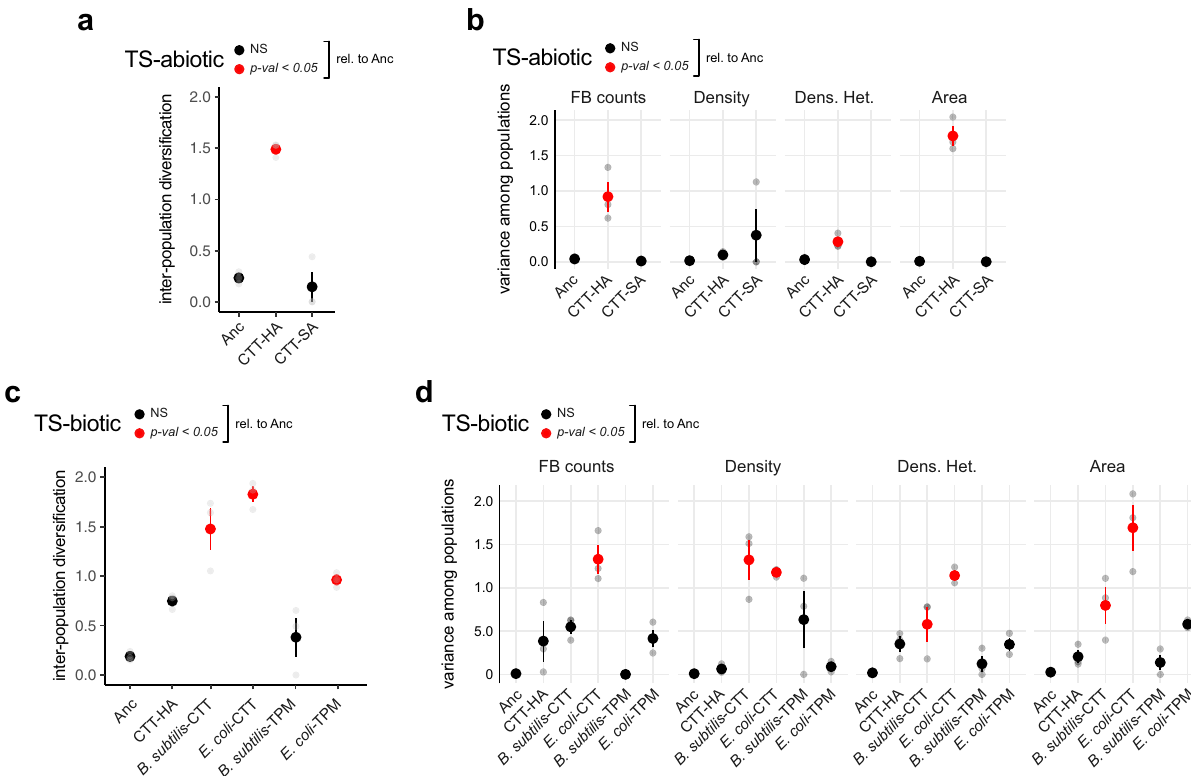
Fig. 5 Deterministic limitation of stochastic latent-phenotype diversi fi cation by MyxoEE-3 selective environments. a , c Morphological diversity among replicate TS-abiotic ( a ) and TS-biotic ( c ) populations evolved in the same selective environment compared to diversity among Anc subclones. b , d Variance of single morphological traits distributions calculated across TS-abiotic ( b ) and TS-biotic ( d ) evolved populations and across the Anc subclones. In all cases, large circles represent mean values ± SEM of three independent biological replicates (gray circles, n = 3), while red and black circles indicate signi fi cant ( p < 0.05) and non-signi fi cant (NS) differences from Anc levels, respectively. (Signi fi cance was calculated in all cases with one-way ANOVA followed by two-tailed Tukey tests. p values of all comparisons of evolved treatments with Anc, as well as all pairwise comparisons between evolved treatments, are reported in Data Fig.